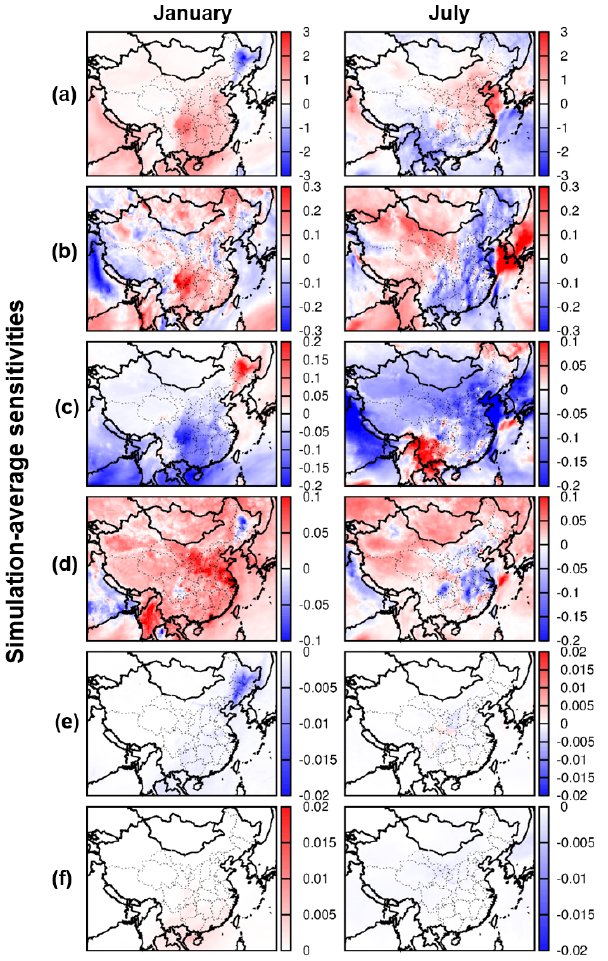
Figure 9. Sensitivity of the PM 2 . 5 mean to meteorological pertur- bations (a) T , (b) WS, (c) AH, (d) PBLH, (e) CLW, and (f) PCP in China. The value in T is measured in µgm − 3 K − 1 and others in µgm − 3 % − 1